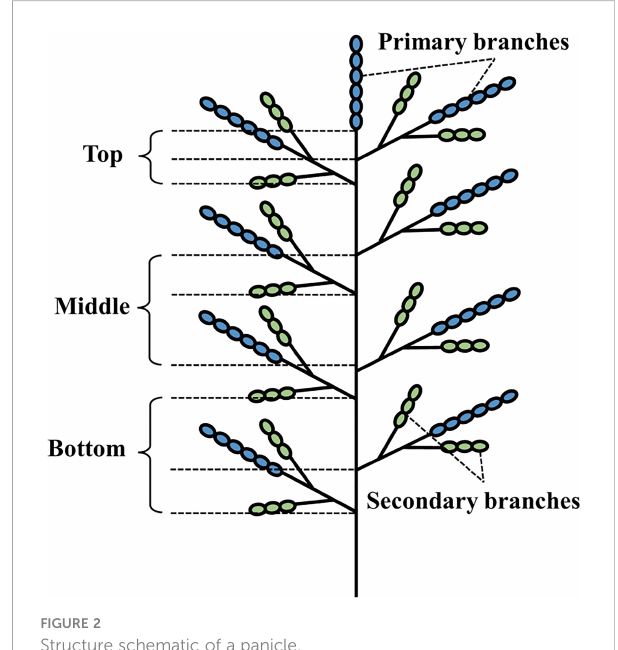
FIGURE 2 Structure schematic of a